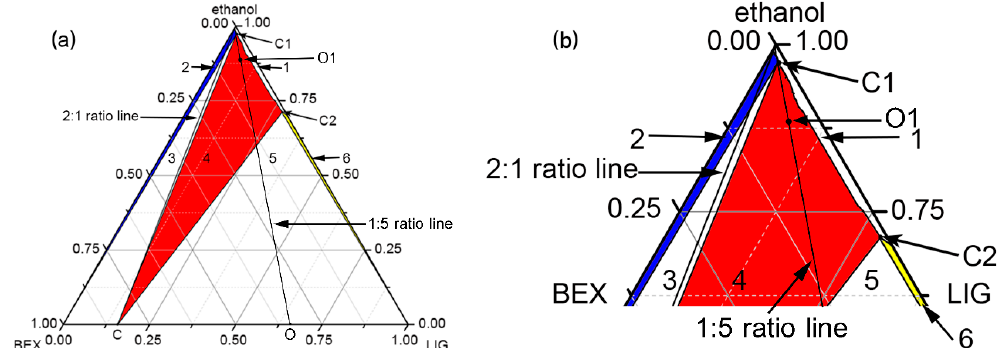
Figure 2. Ternary phase diagram of 2bexarotene- ligustrazine (2BEX-LIG) in ethanol at 20 °C drawn with OriginPro 8.5 software: the phase diagram was divided into six regions, where region 1 represents the unsaturated solution phase and regions 2 (highlight in blue), 4 (highlight in red), and 6 (highlight in yellow) represents the phase equilibrium between solution and the solid phases of BEX, co-crystal, and LIG, respectively. Regions 3 and 5 represent the coexistence of the co-crystal with BEX and LIG, respectively. The black lines represent the 2:1 and 1:5 molar ratios of BEX and LIG, respectively; point C represents the solid co-crystal; point O represents the mixture of BEX and LIG in molar ratio 1:5; point O1 represents the experiment condition of slurry; and C1 and C2 are invariant points in the system. ( a ) The full image; ( b ) zoom on the upper part (about 1.7-fold magnified).